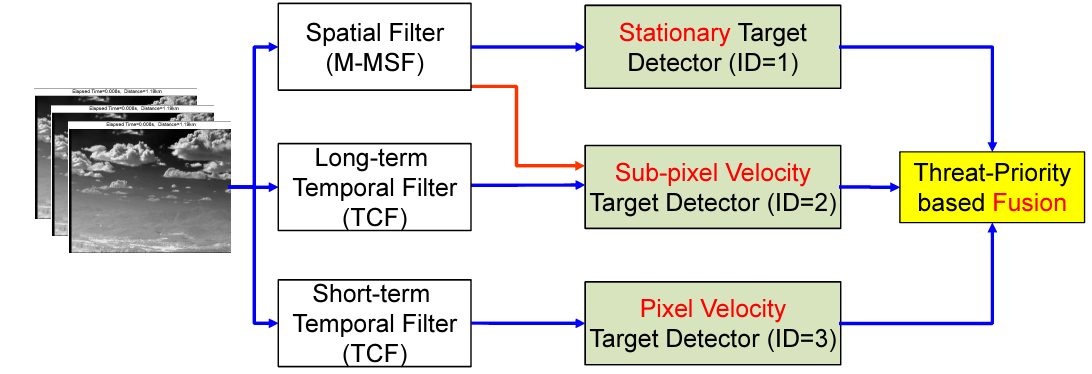
Figure 11. Proposed incoming target detection system. The system consists of basic filtering parts (M-MSF, TCF), speed-related detection parts and the detector fusion